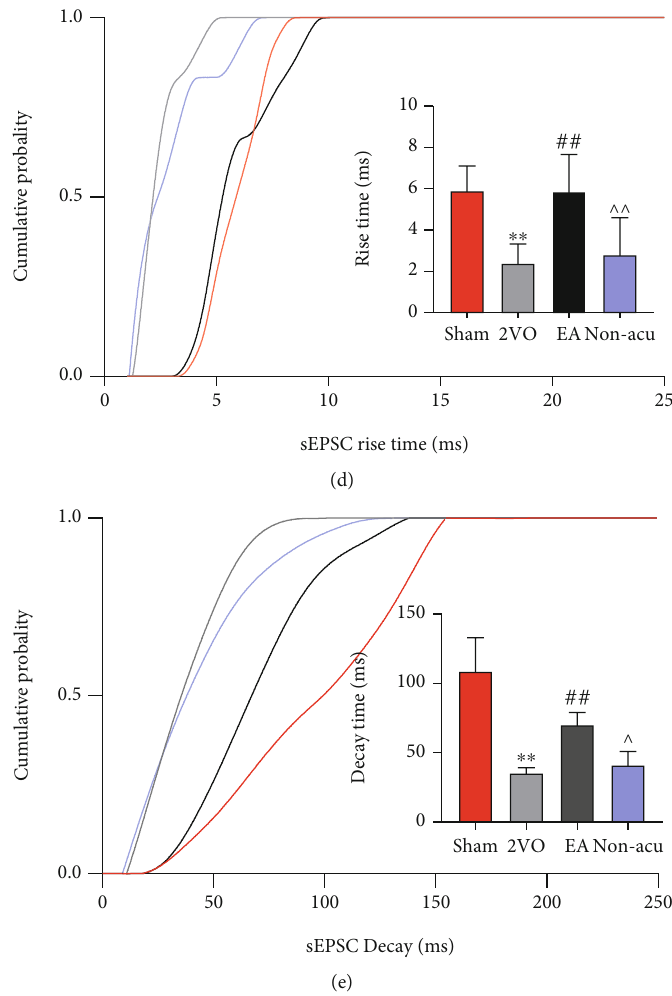
Figure 3: Electroacupuncture improves synaptic transmission rate of hippocampal neuron. (a) Representative sEPSC traces. (b) Cumulative probability plots showing change in sEPSC amplitude (left). The histogram shows the di ff erence in amplitude between groups (right). (c). Cumulative probability plots showing change in sEPSC frequency (left). The histogram shows the di ff erence in frequency between groups. (d) Decay time of sEPSC. (e) Rise time of sEPSC. ∗ P < 0 : 05 and ∗∗ P < 0 : 01 , Sham vs. 2VO; # P < 0 : 05 , 2VO vs. EA; ^ P < 0 : 05 , EA vs.